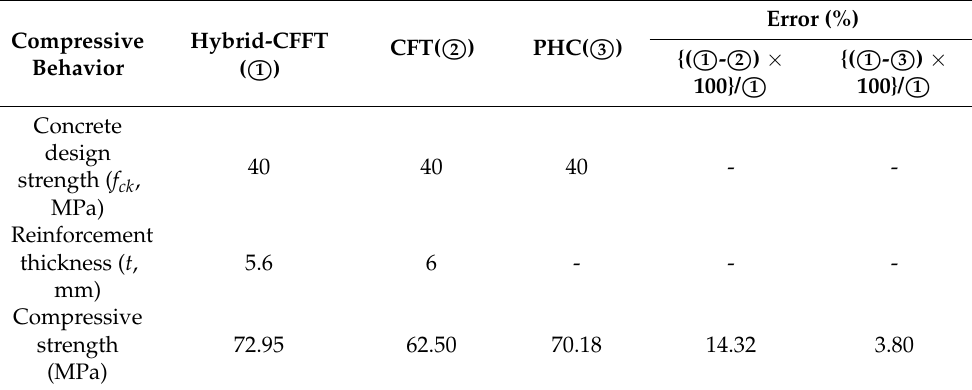
Table 12. Compressive strength comparison of hybrid − CFFT, CFT, and PHC